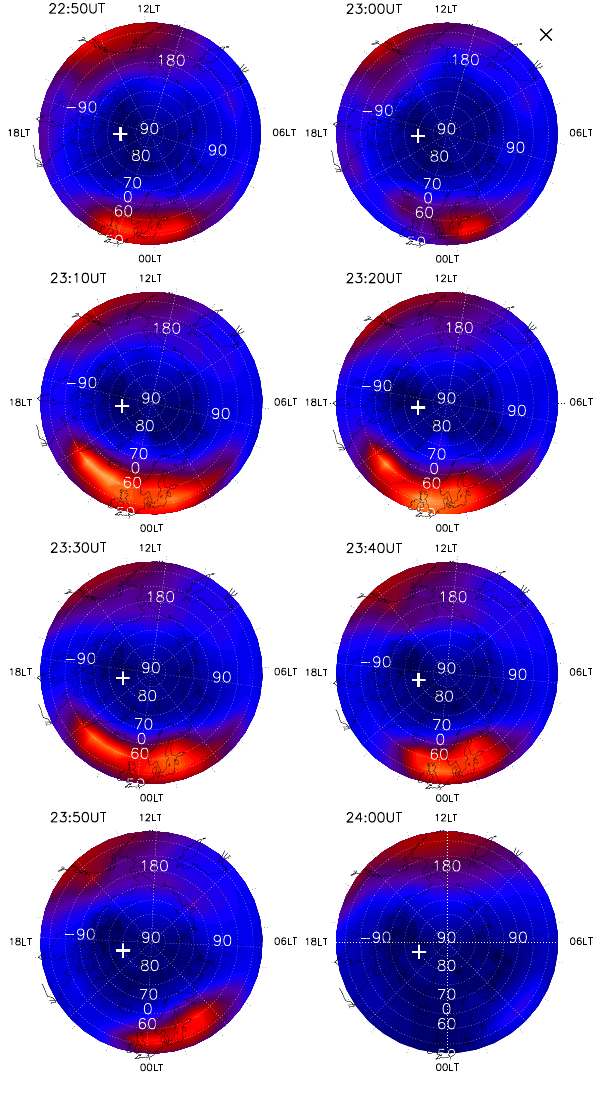
Fig. 4. As for Fig. 3.